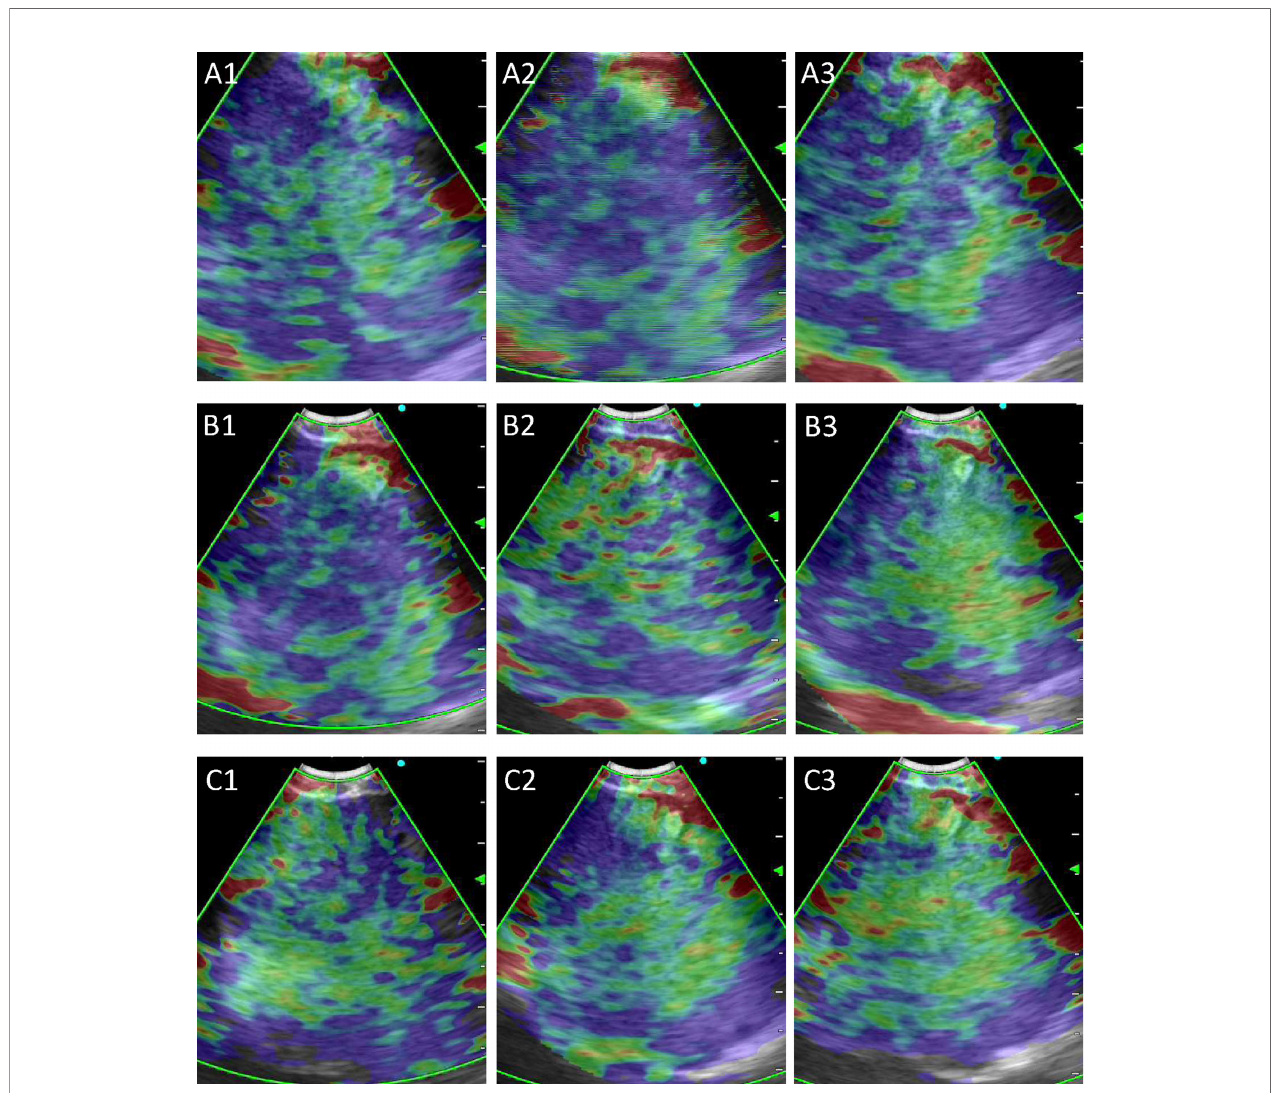
FIGURE 3 | Representative images selected by machine learning, expert and trainee groups. (A) 1 – 3 are representative images selected by the machine learning model; (B) 1 – 3 are representative images selected by the three experts; (C) 1 – 3 are representative images selected by the three trainees.